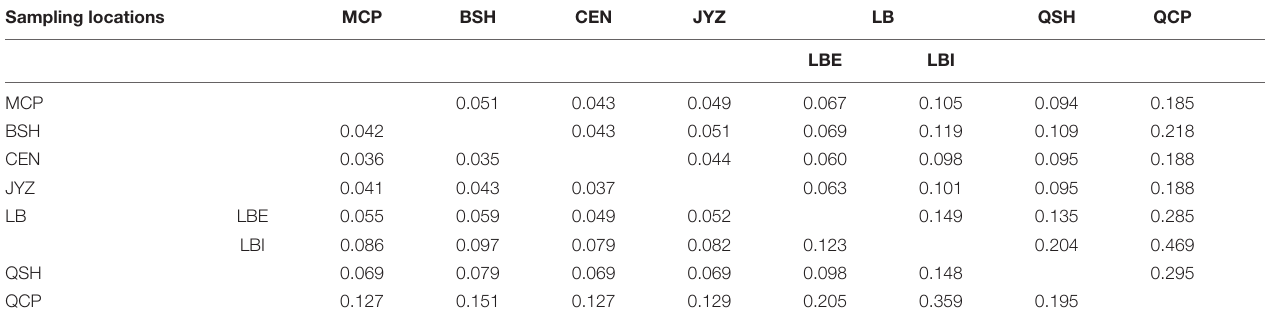
TABLE 2 | Genetic differentiation coefficient ( F ST ) between each sampling location and the two genetic groups in LB. Sampling